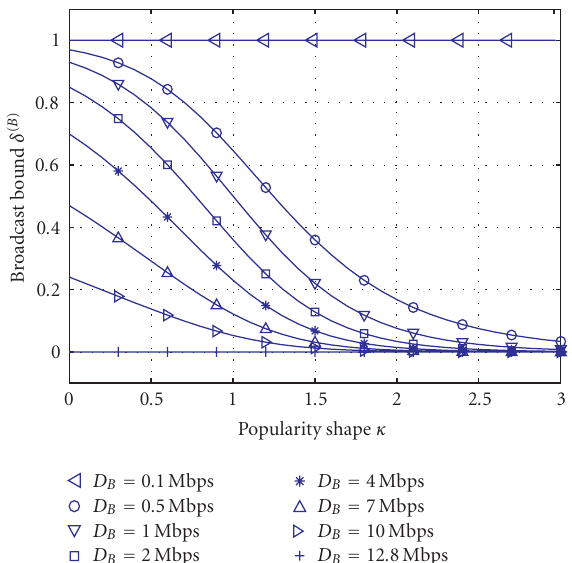
Figure 4: Cellular bound δ ( C ) for cell i depending on the load share i parameter β and the total o ff ered tra ffi c